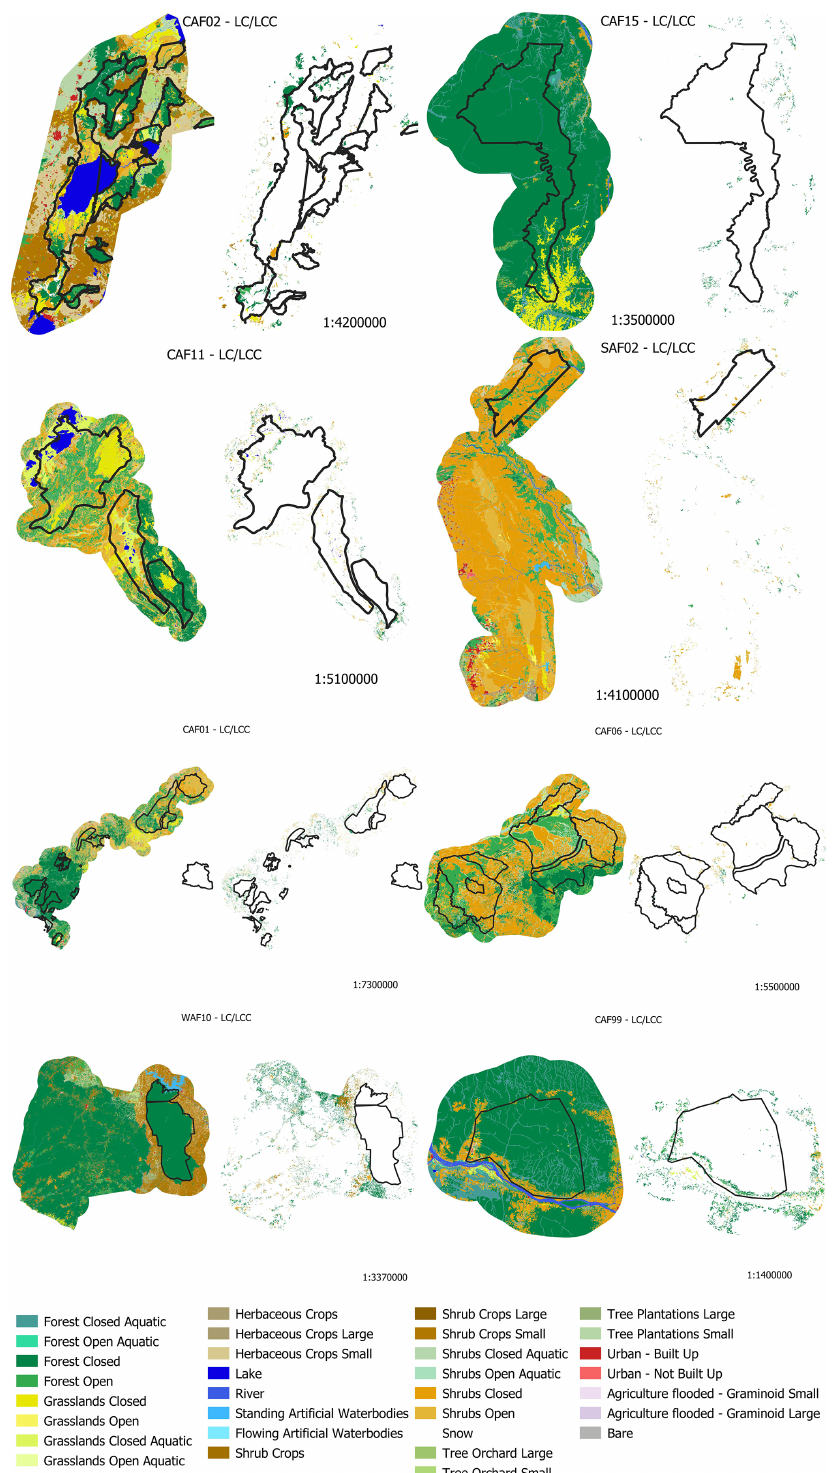
Figure 5. Key landscapes for conservation – Modular classification level. The boundaries (black polygons) represent protected areas (IUCN categories I–IV) within the KLCs. Both land cover and land cover change are presented for each